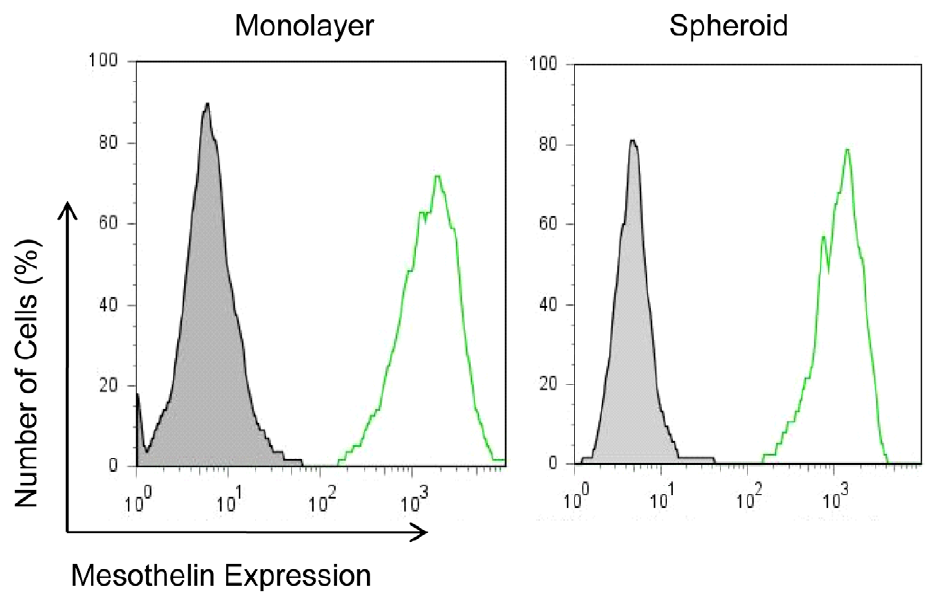
Figure 3. Mesothelin expression in mesothelioma monolayers and spheroids. NCI-H226 cells incubated with an anti-mesothelin mAb (MN) and detected with goat anti-mouse IgG conjugated with Alexa488 by flow